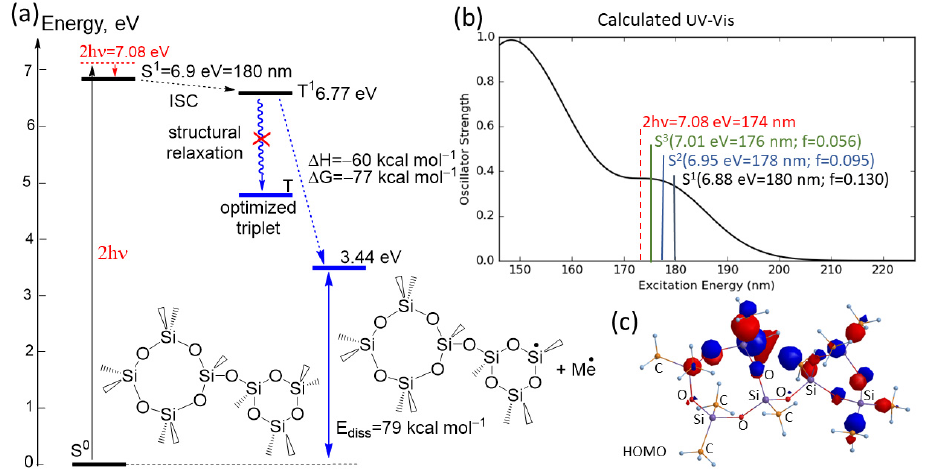
Figure 8. ( a ) Jablonski energy scheme of the population of the reactive triplet by two-photon excitation of the studied model molecule. ( b ) Calculated UV-Vis spectra; f-oscillator strength. ( c ) Electron distribution of σ -electrons from HOMO involved in the formation of the first S 1 excited state.